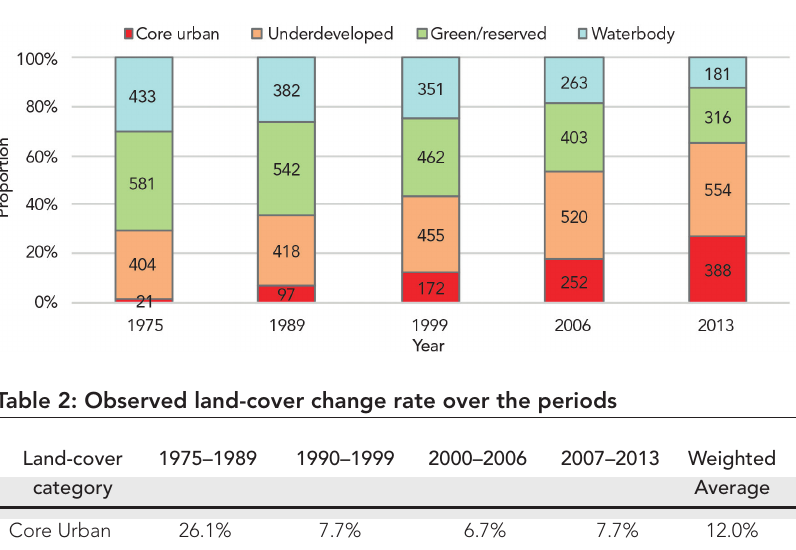
Figure 2: Proportion and area (in km 2 ) of different land-cover categories during collected data periods